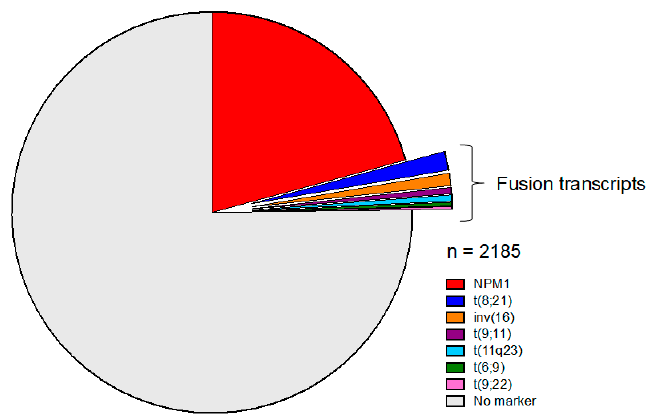
Figure 1. Prevalence and distribution of standardised molecular Minimal Residual Disease (MRD) targets in adults >65 years entering the National Cancer Research Institute (NCRI) Acute Myeloid Leukemia (AML)-16 trial [47].